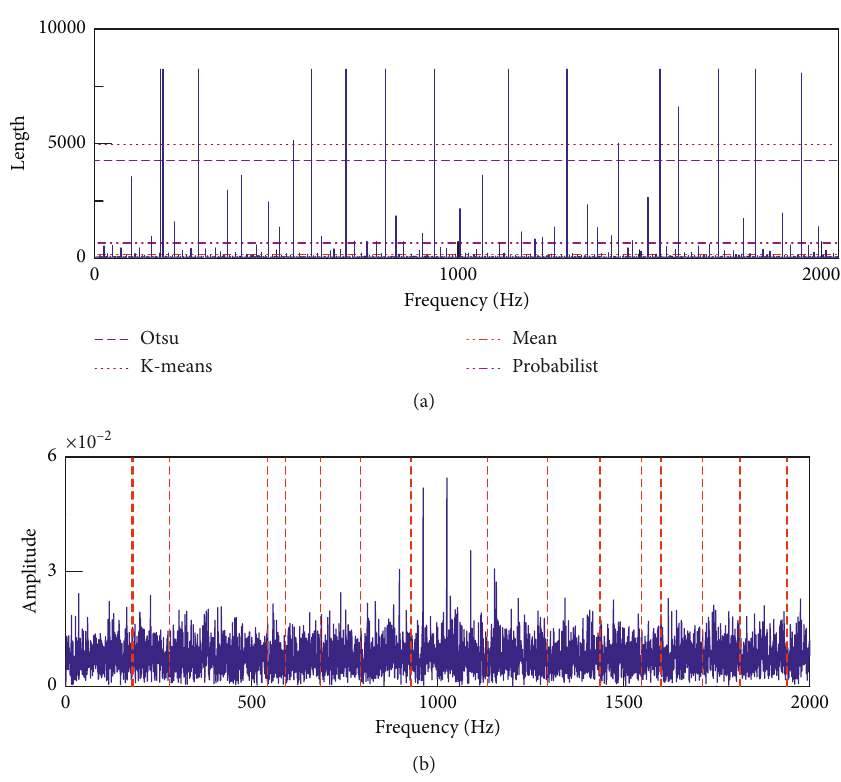
Figure 4: (a) The SSP and the classification thresholds; (b) the detected boundaries.